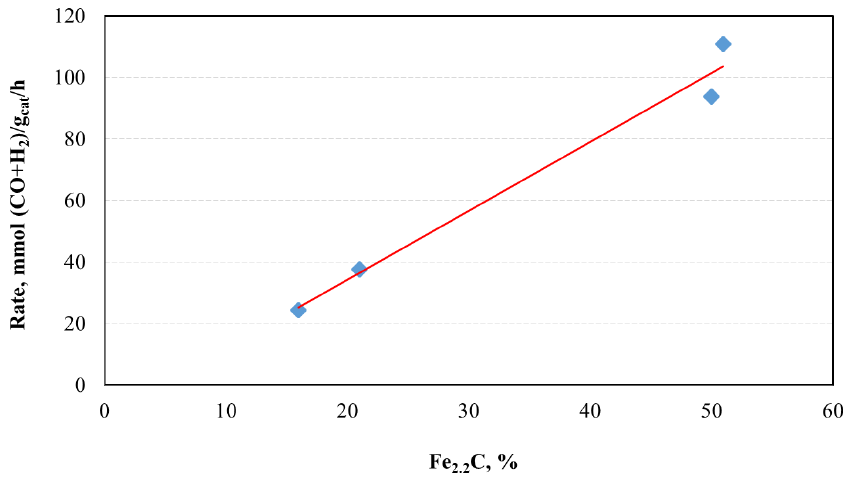
Figure 9. Correlation of catalyst activity with iron carbide content.